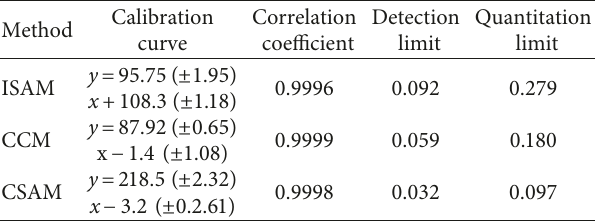
Table 7: Detection and quantitation limits for three methods.